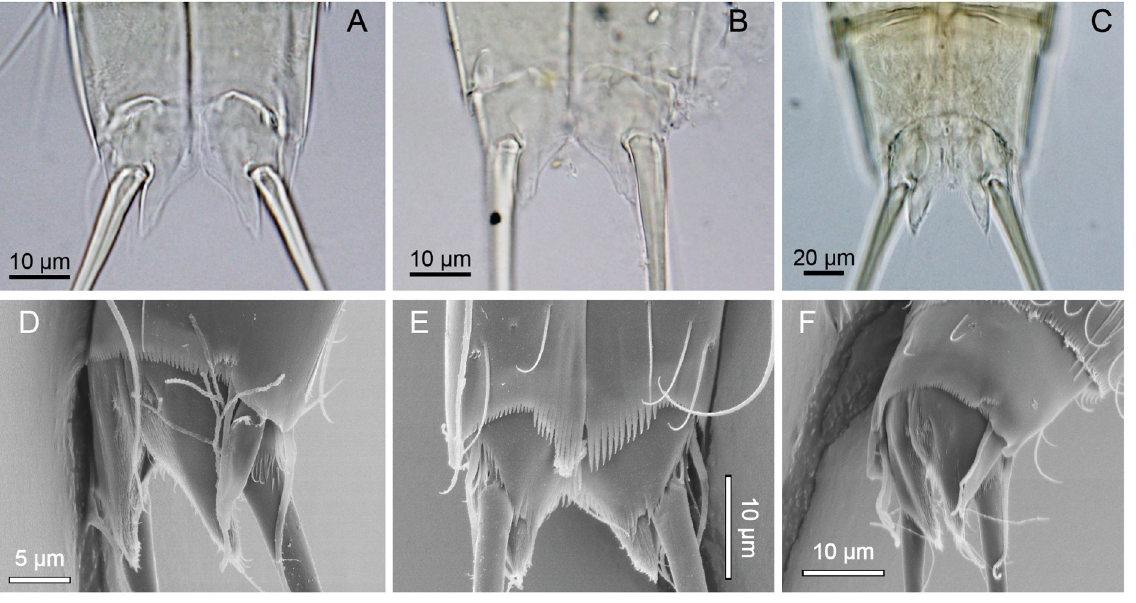
Fig. 32. Segment 11 and morphological variations of tergal extensions in Echinoderes sp. aff. E. galadrielae / E. beringiensis . A–C . Light micrographs. D–F . Scanning electron